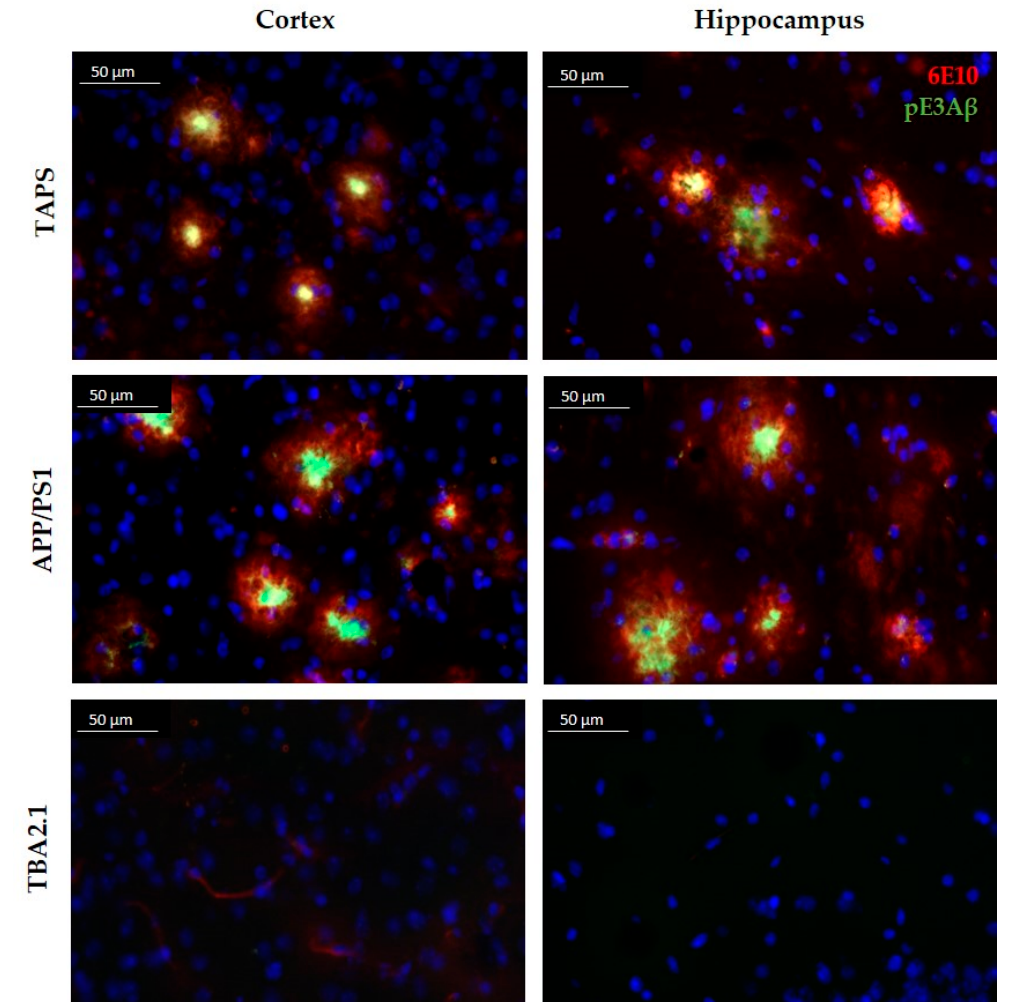
Figure 1. Comparison of the plaque morphology in TAPS, APP/PS1, and TBA2.1 mice. Sagittal slices stained with 6E10 (red) for whole amyloid- β (A β ), and pE3 antibody (green) for truncated pyroglutamate A β (pE3A β ) species at 400 × magnification. Intense labeling of pE3A β in the center core of A β plaques was visible in the cortex of TAPS and APP/PS1, as well as in the hippocampus (CA3 region). No A β accumulation was visible in the cortex and hippocampus of heterozygous TBA2.1 mice. Cell nuclei labeled by DAPI (blue). Images of representative animals are shown; for total animal numbers, see Table 1.